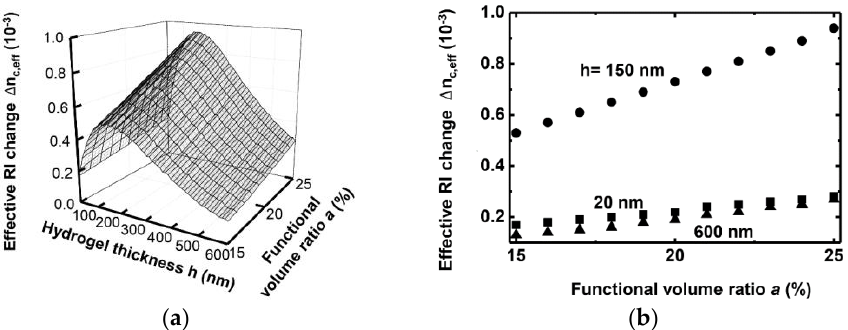
Figure 5. ( a ) ∆𝑛 𝑐,𝑒𝑓𝑓 as a function of the functional volume ratio 𝑎 for various hydrogel thicknesses and ( b ) ∆𝑛 𝑐,𝑒𝑓𝑓 for specific hydrogel thicknesses of 20, 150, and 600 nm. The RI of the reacted hydrogel 𝑛 ℎ,𝑢𝑝 has a constant value of 1.39 for all 𝑎 .